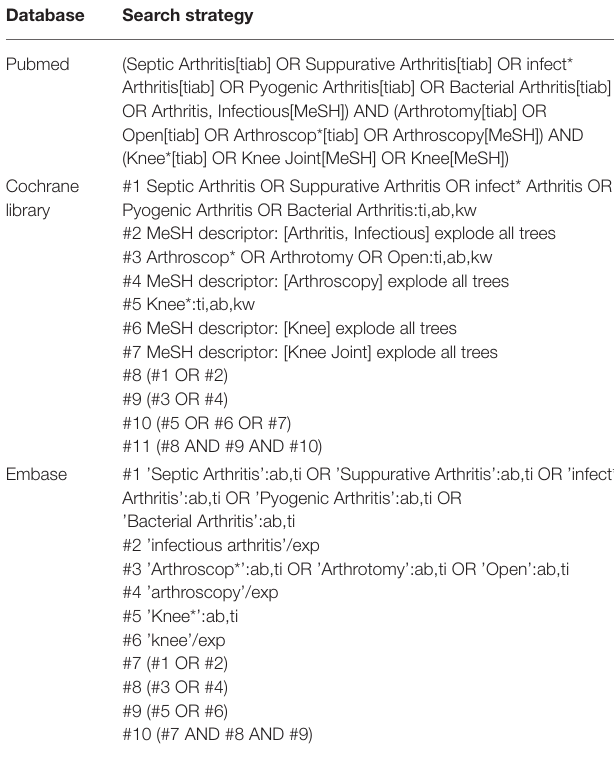
Database Search strategy